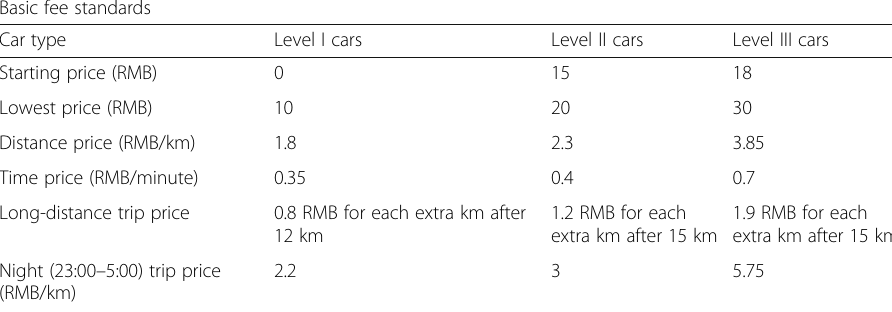
Table 1 Fees of car-hailing service on Platform W Basic fee